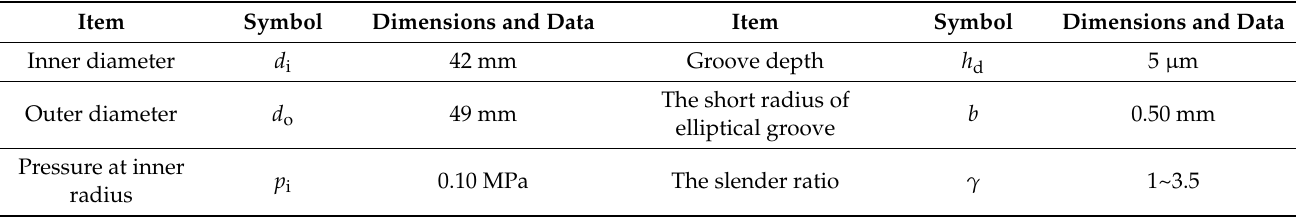
Table 1. Parameters of the mechanical face